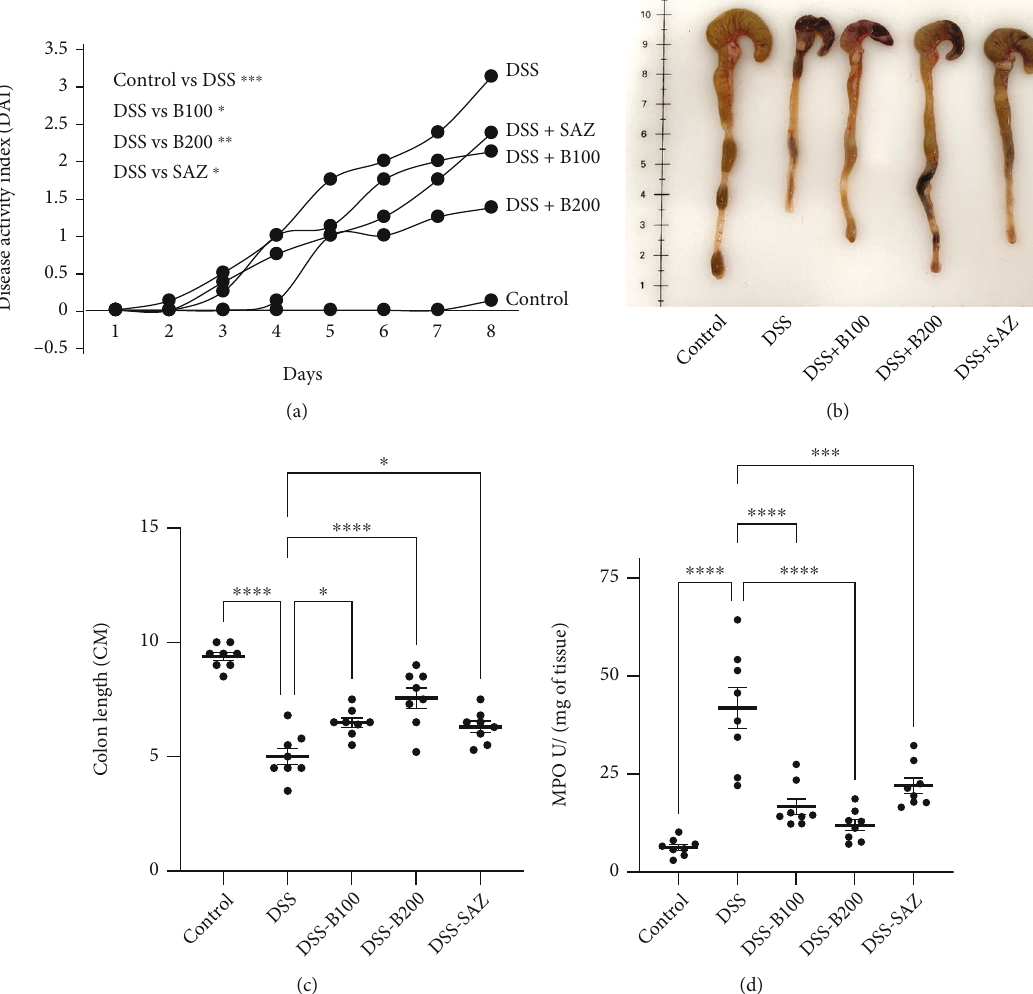
Figure 2: E ff ect of bisabolol on Disease Activity Index (DAI), colon length, and myeloperoxidase (MPO) activity. DSS administration increased DAI scores, bisabolol ,and SAZ signi fi cantly reduced OR prevented the increase in the DAI scores (a). DSS administration signi fi cantly reduced the colon length, and bisabolol and SAZ treatment prevented a decrease in colon length (b, c). DSS administration markedly increased colonic MPO activity. Bisabolol and SAZ signi fi cantly prevented the increase in MPO activity (e). Eight to ten animals were used in each group to determine statistical signi fi cance. For DAI, the statistics were performed on day eight on the cumulative DAI scores. The data expressed as mean ± SEM . ∗ p < 0 : 05 , ∗∗ p < 0 : 01 , ∗∗∗ p < 0 : 001 , and ∗∗∗∗ p < 0 : 0001